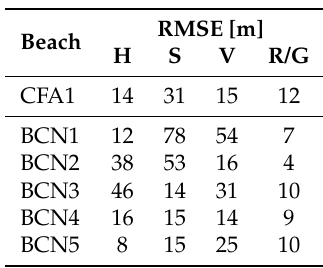
Table 5. RMSE in meters of the shorelines obtained with the four initial raw methods (Hue, Saturation, Value and the ratio Red/Green) for each beach, including all studied